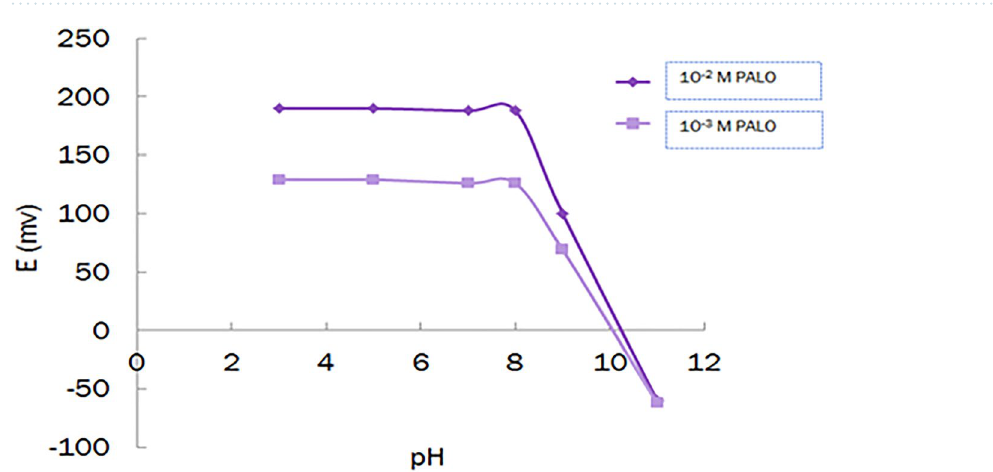
Figure 2. Effect of pH on the performance of ionophore-free